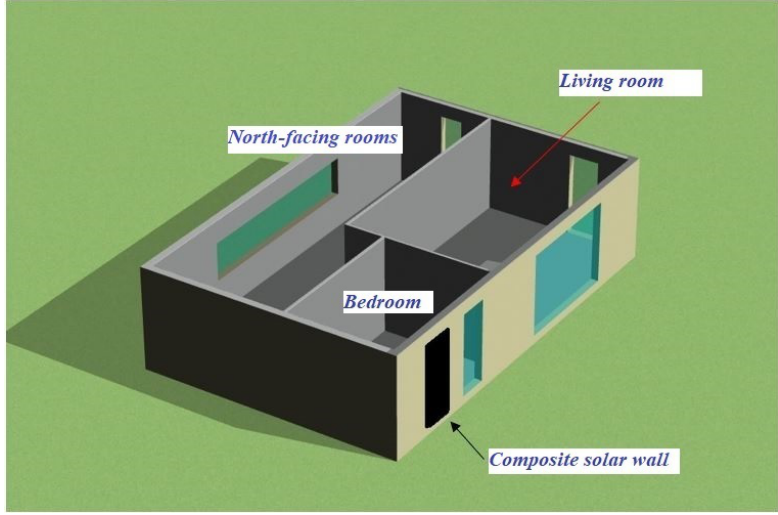
Figure 1. 3D house layout. Table 1. Constructive characteristics of the studied